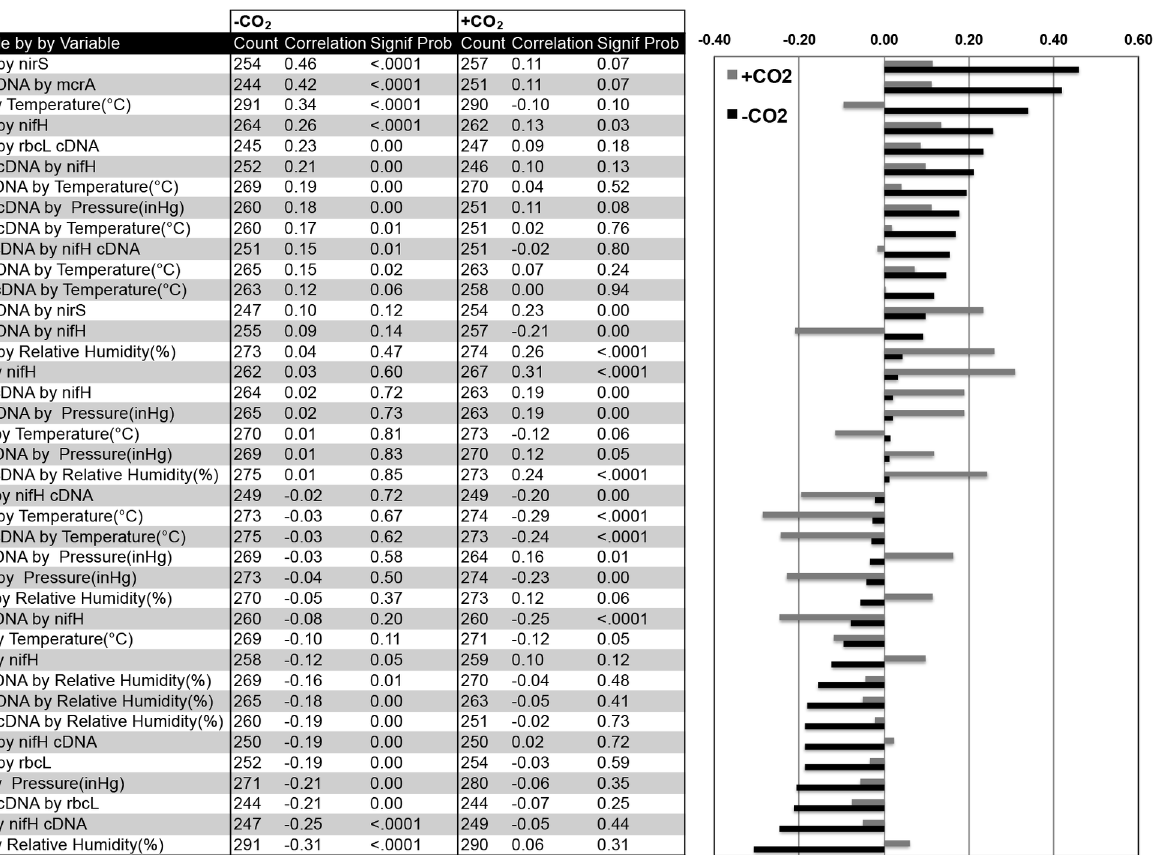
Figure 3. Changes in pairwise correlation between different variables in response to CO were compared independently for background and CO response to CO are presented. Non-parametric version of this figure can be found in Table S4, with full statistical results in Tables 2 S5 and